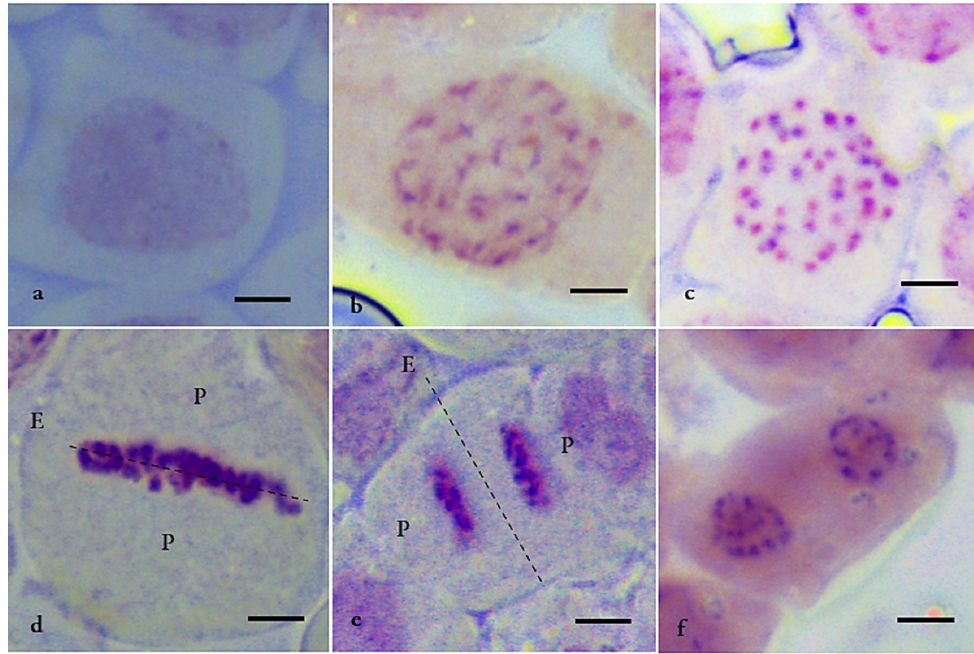
Figure 2. Different stages of division of tetraploid cell of N. cadamba , (a) interphase, (b) prophase, (c) pro- metaphase, (d) metaphase, (e) anaphase and (f) telophase (Bar = 5µm) (P = pole; E =